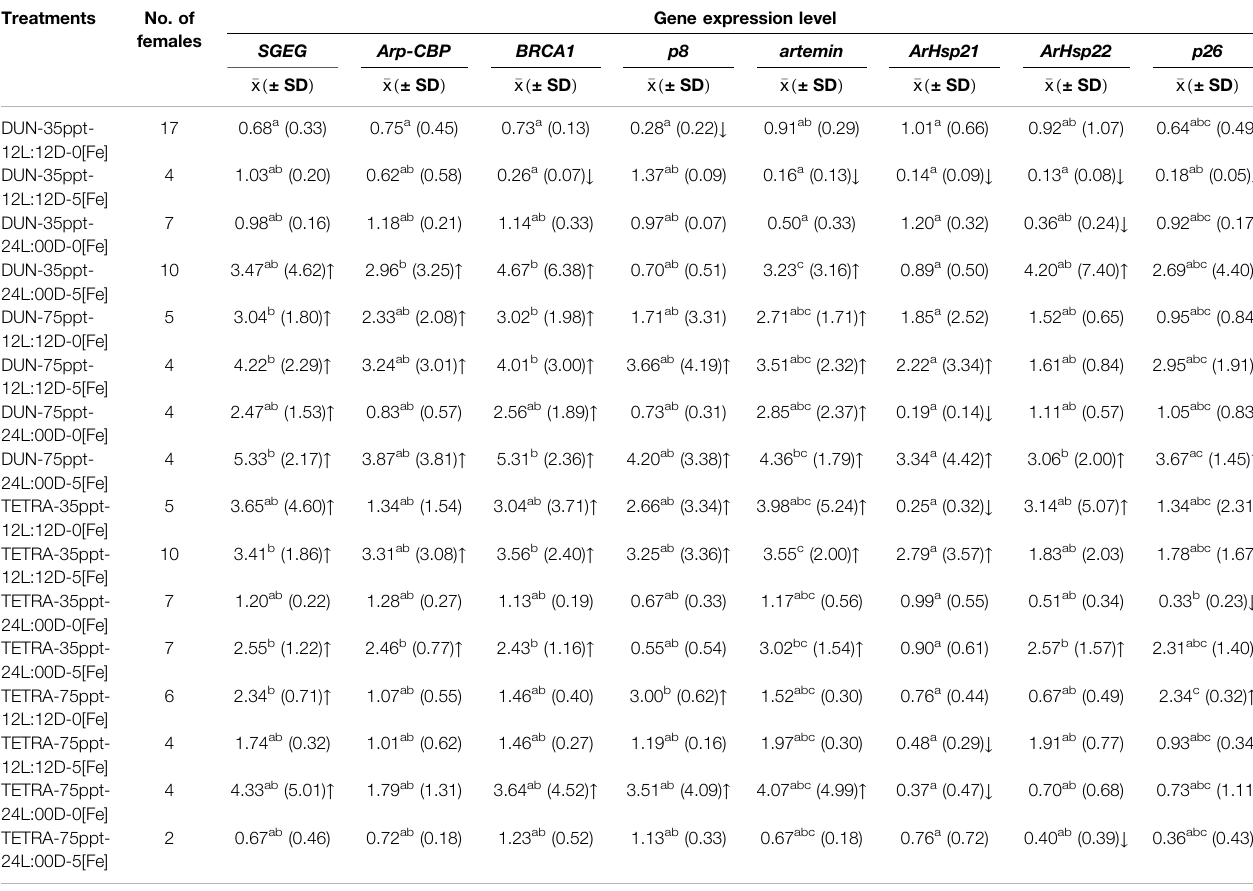
TABLE 6 | Gene expression level in the Barro Negro population. Treatments No. of